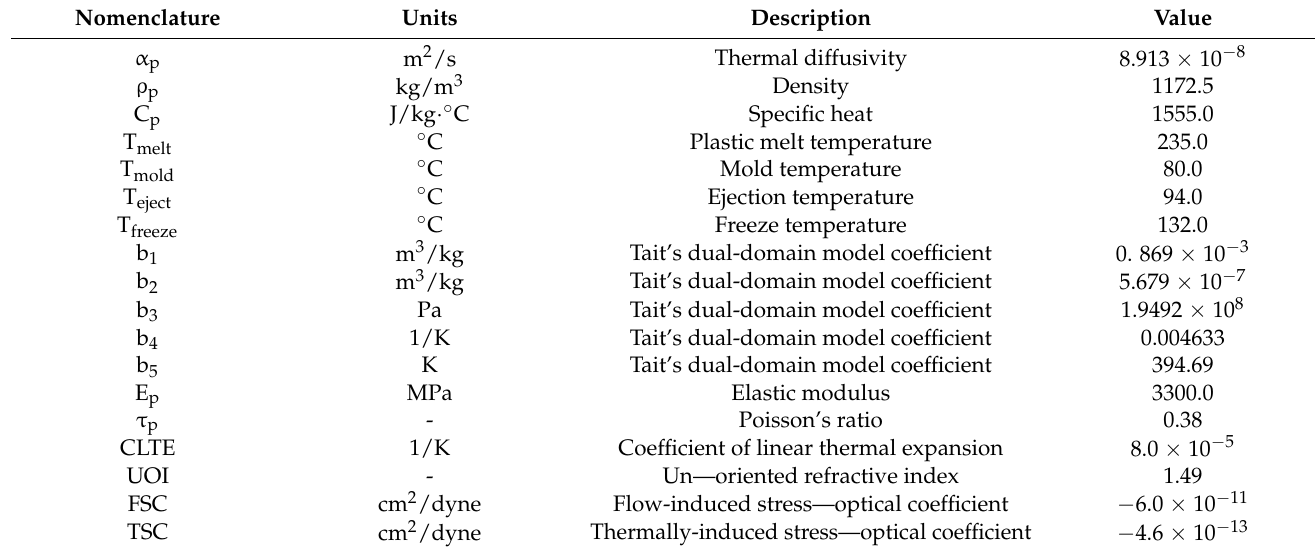
Table 2. Magnitude of the main properties of the material Plexiglas